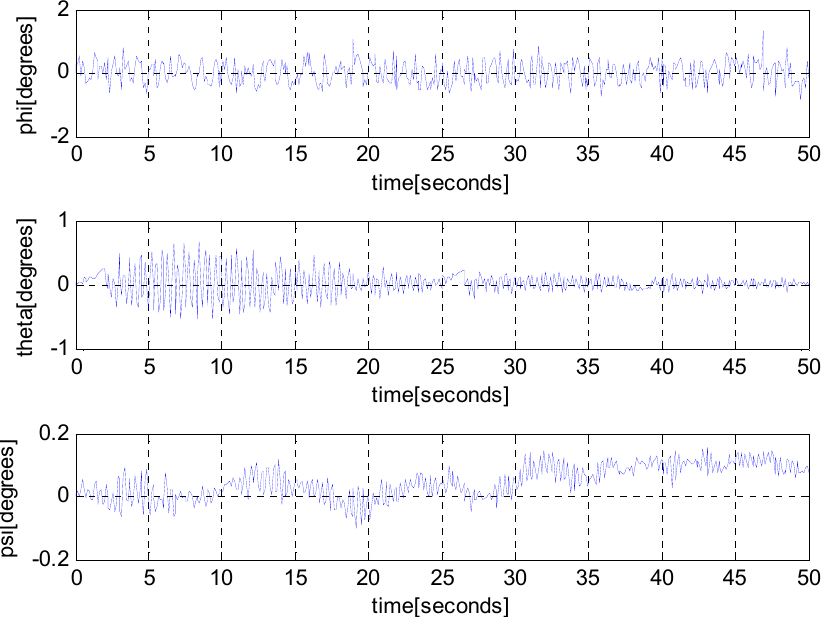
Figure 8. The change of ϕ,θ,ψ with respect to time (controllers considering noisy environments and fuel consumption).